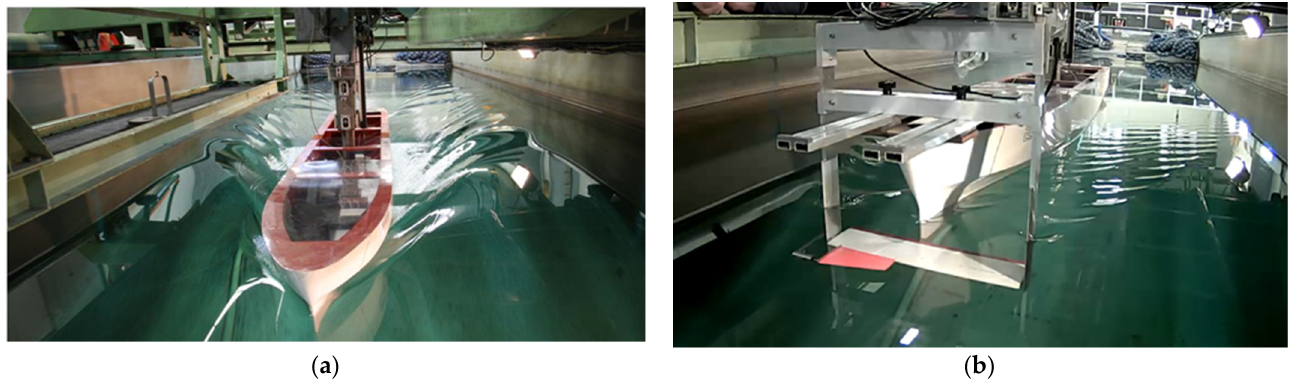
Figure 5. Tank tests of the hull model in calm water: ( a ) without the dynamic wing and ( b ) with the flapping thruster, and determination of resistance.